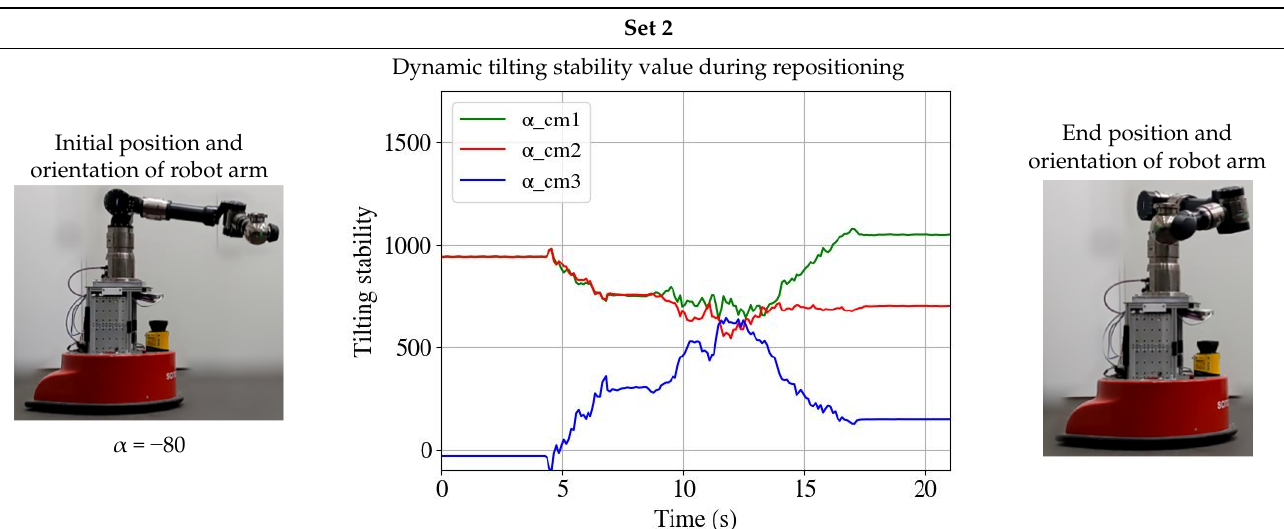
Table 4. Comparative scenarios in order to verify the effectiveness of the active stabilization using Table 4. Cont. the real mobile